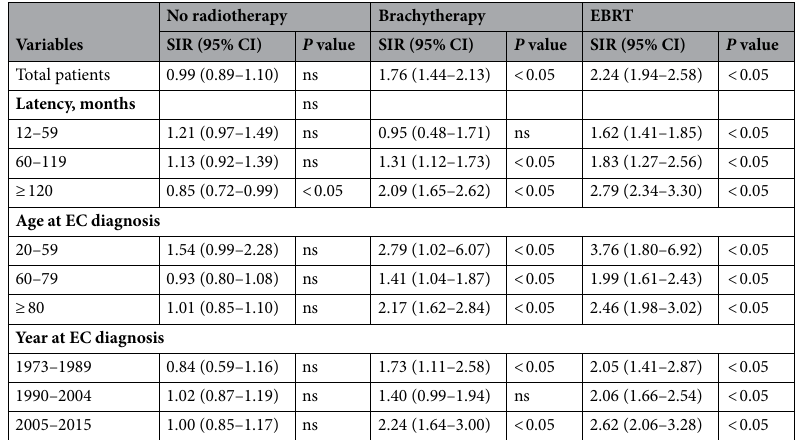
Table 2. Standardized incidence ratio of secondary bladder cancer in EC patients. SIR, standardized incidence ratio; EC, endometrial cancer; EBRT, external-beam radiotherapy; ns, no significance.